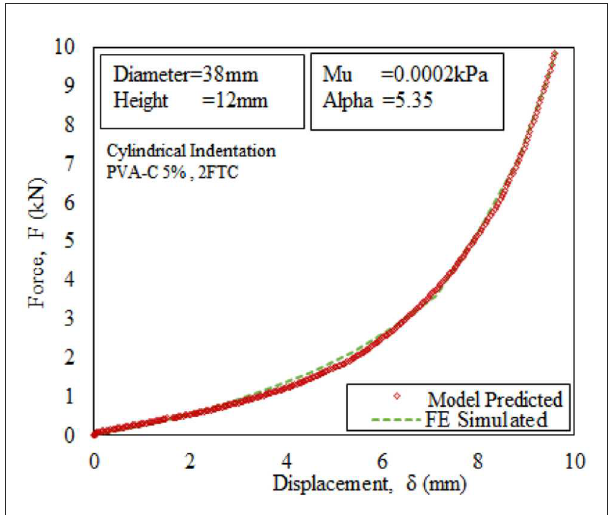
FIGURE8 Load vs. displacement graph for PVA-C sample with finite thickness and 5% concentration.